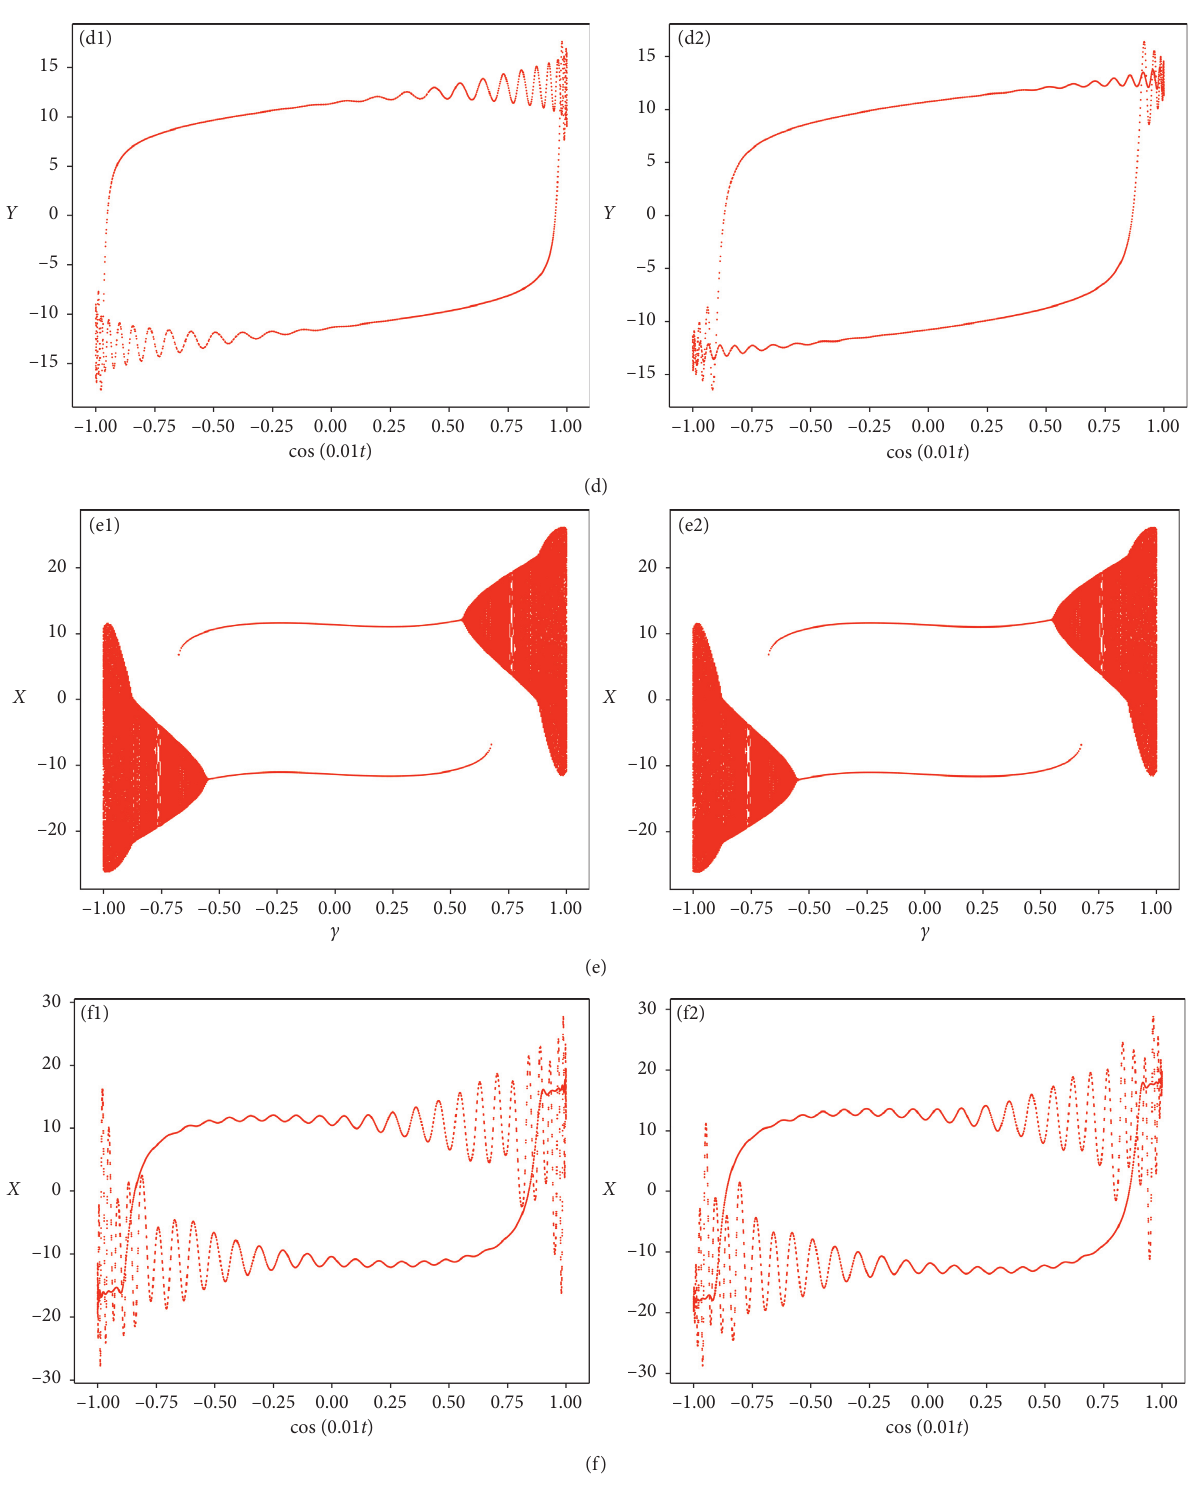
Figure 9: Fast-slow analysis of the bursting ( a ,a ) , ( b , b ) , and ( c , c ) ( a 1 2 1 2 1 2 frequency (see Figure 12). It is shown that the yellow curve agrees well with the red curve, i.e., the bursting pattern in Figure 12(a) with 10 − 2 -grade truncated frequency agrees